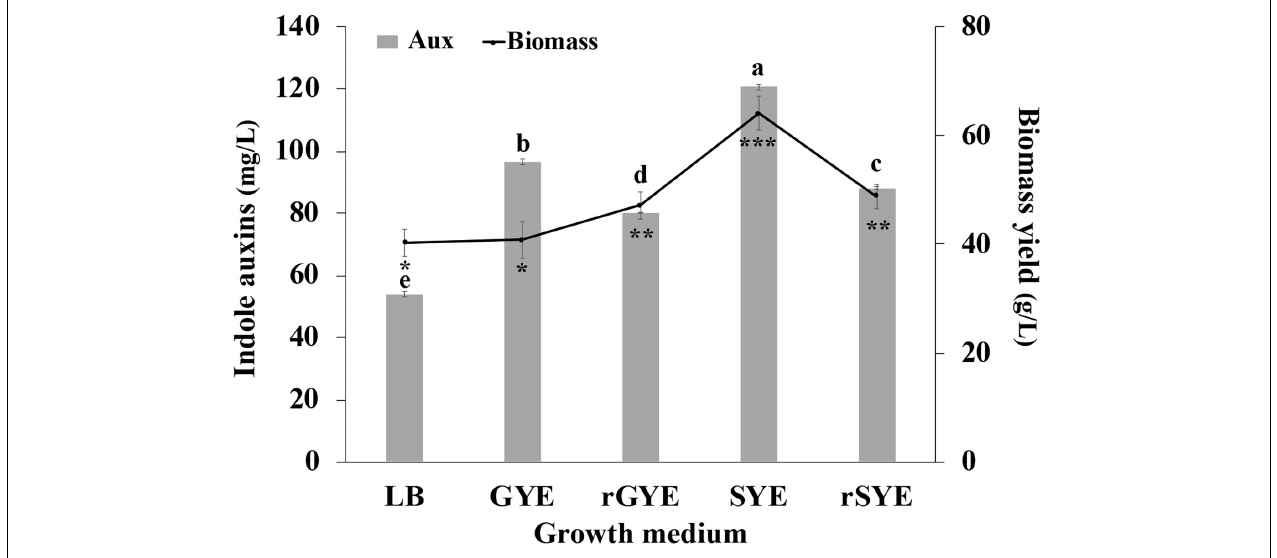
FIGURE 6 | Effect of culture medium on IAA production (mg L − 1 ) and biomass concentration (g [wet weight] L − 1 ). LB, YEG, and YES contained 5 g L − 1 of yeast extract; in reinforced media (rYEG and rYES) the concentration of this ingredient is doubled (10 g L − 1 ). Differences in letters and symbols indicate that the values are significantly different ( P > 0.05).